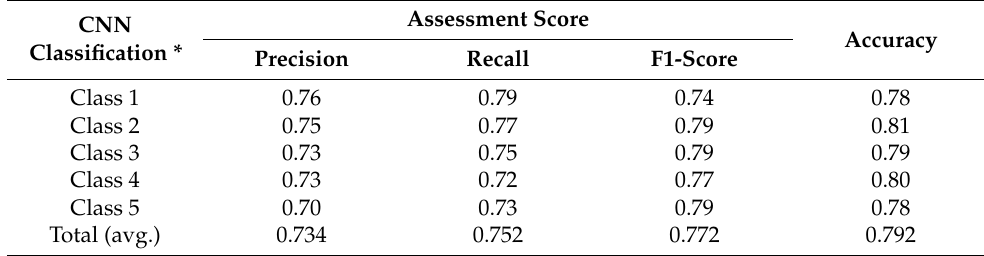
Figure 10. The overlaying results of convolution implementation (CNN-based relevance maps) to estimate the region landslides susceptibility. ( a ) CNN class 1, ( b ) CNN class 2, ( c ) CNN class 3, ( d ) CNN class 4. Table 3. The evaluated confusion matrix for landslide susceptibility